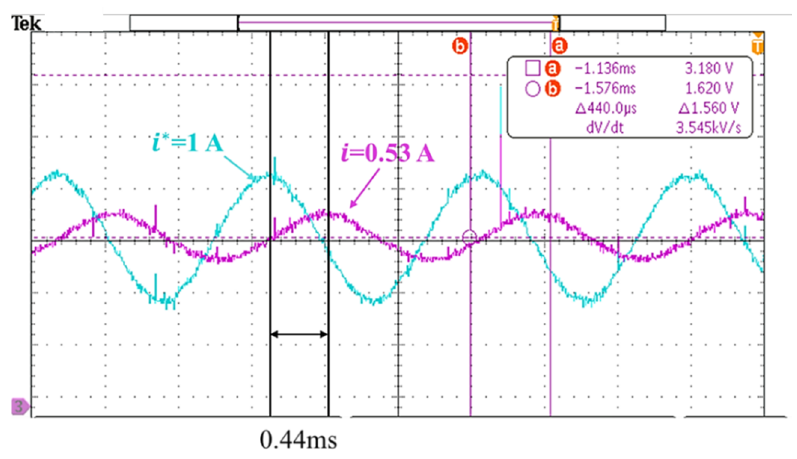
Figure 11. Current loop frequency response verification.